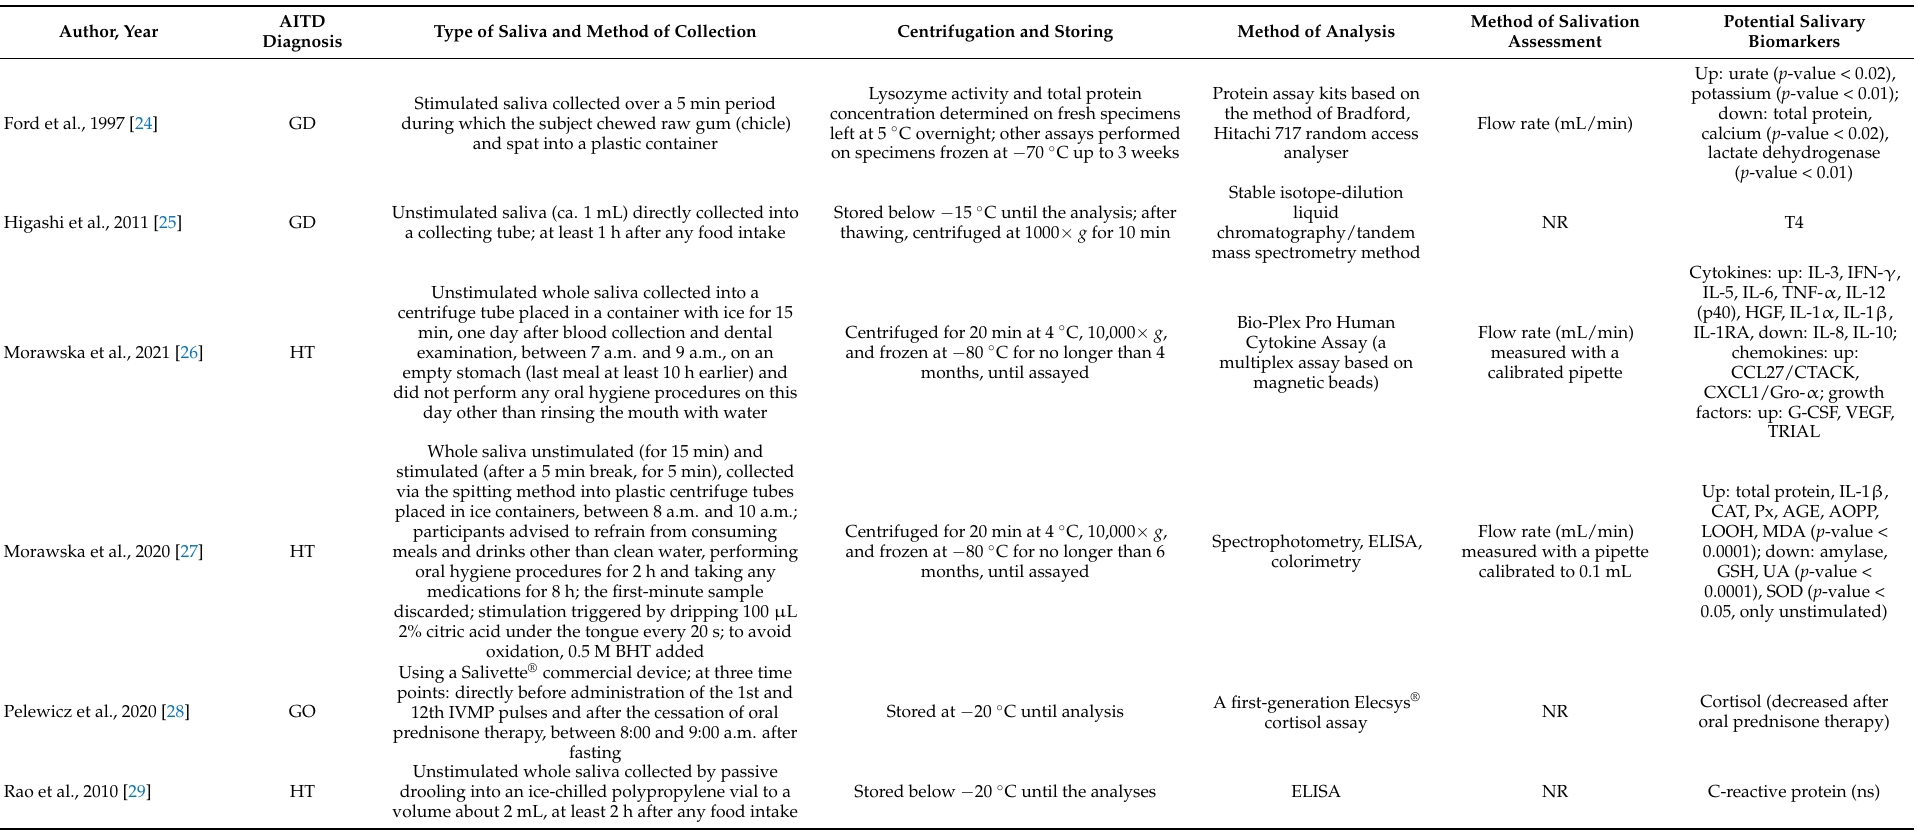
Table 3. Detailed characteristics of included studies considering mainly qualitative assessments of